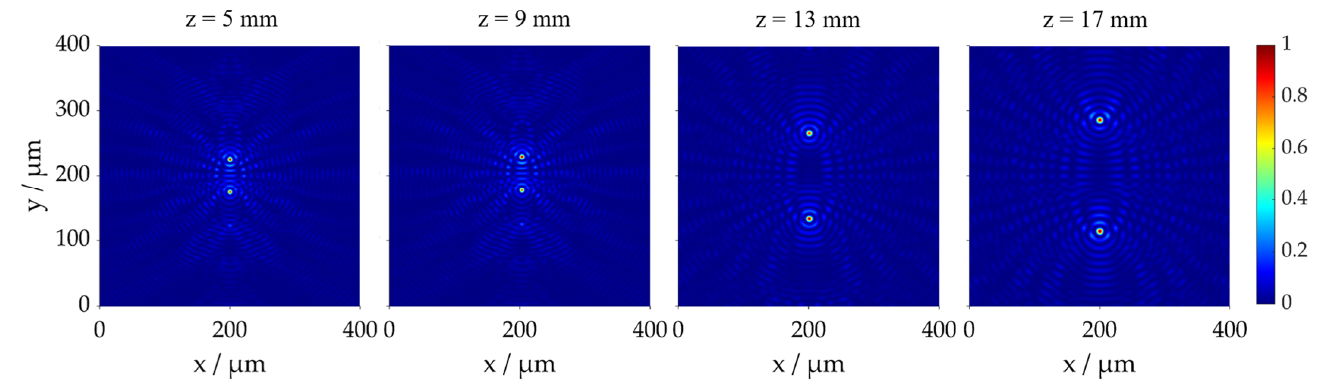
Figure 4. Simulated lateral intensity distributions of the multi-Bessel beam in the focal plane after lens 3 is taken in different z-axis positions from 5 mm to 17 mm in 4 mm steps.